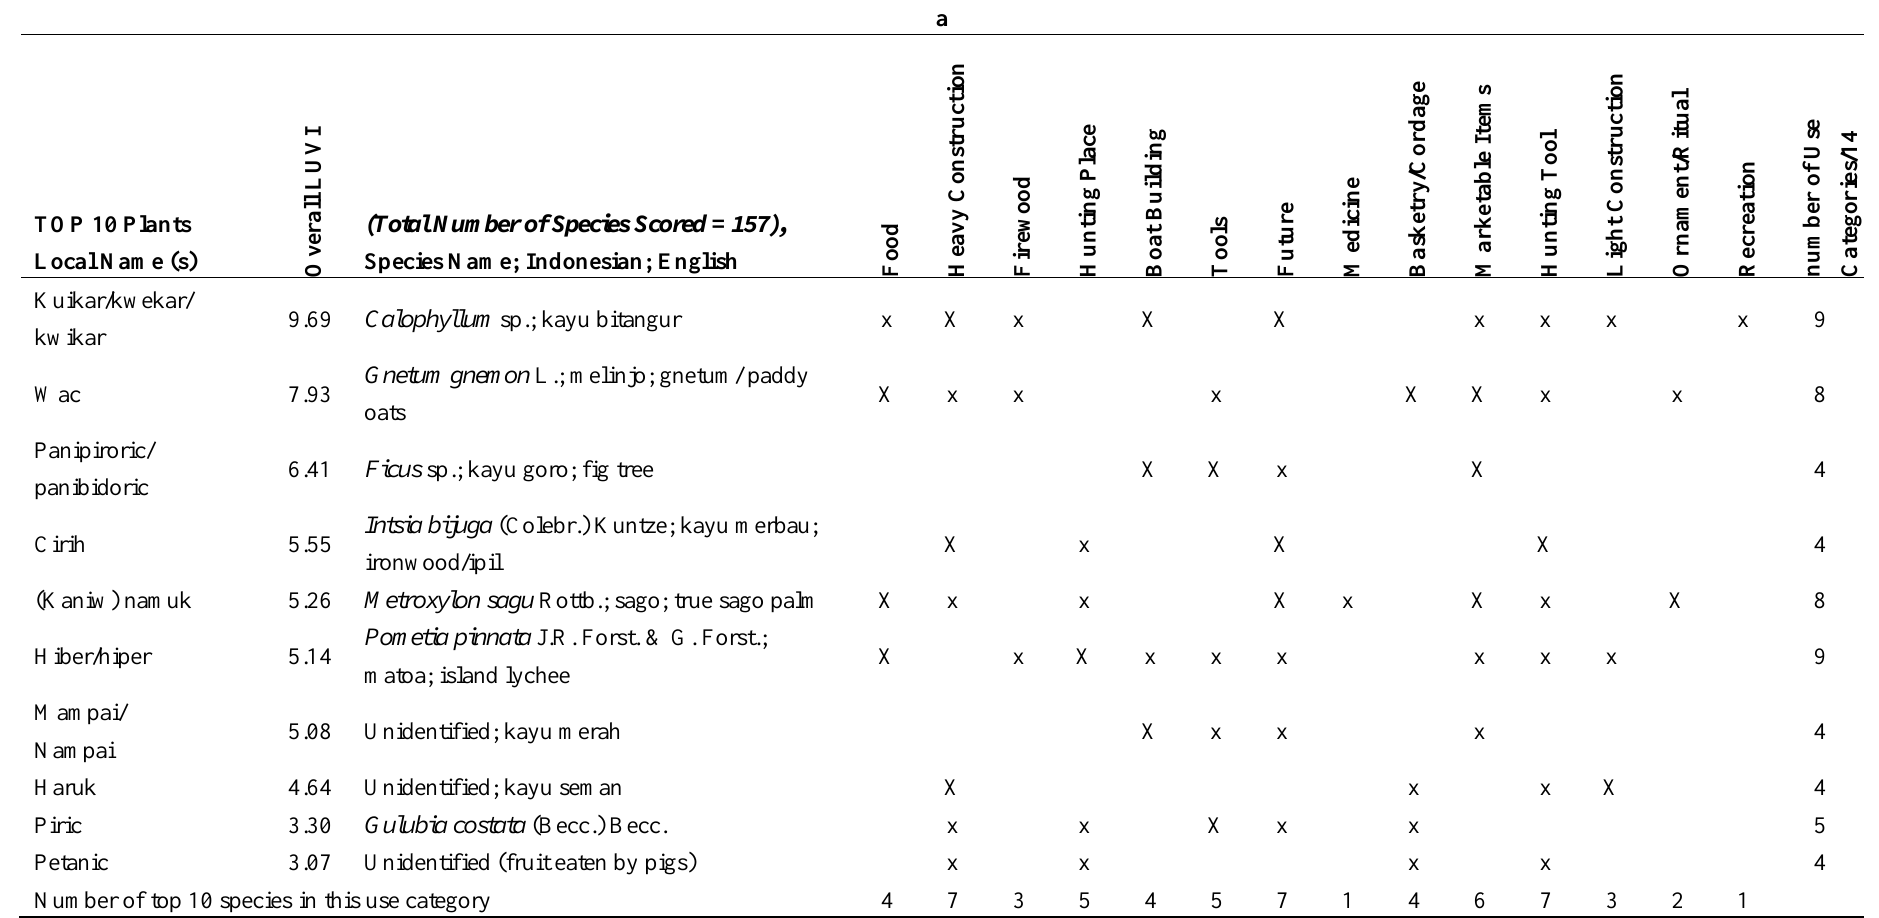
Table 4. The overall most important species of plants (a) and animals